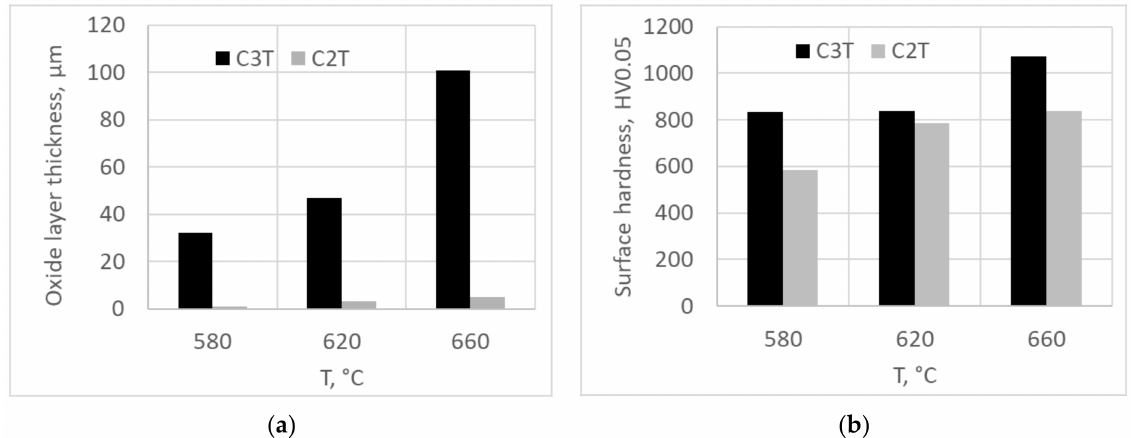
Figure 1. Oxide layer thickness ( a ) and surface hardness ( b ) of samples with and without a pre-deposition layer of Pd/Ag vs. ceramic conversion treatment of 80 h at different